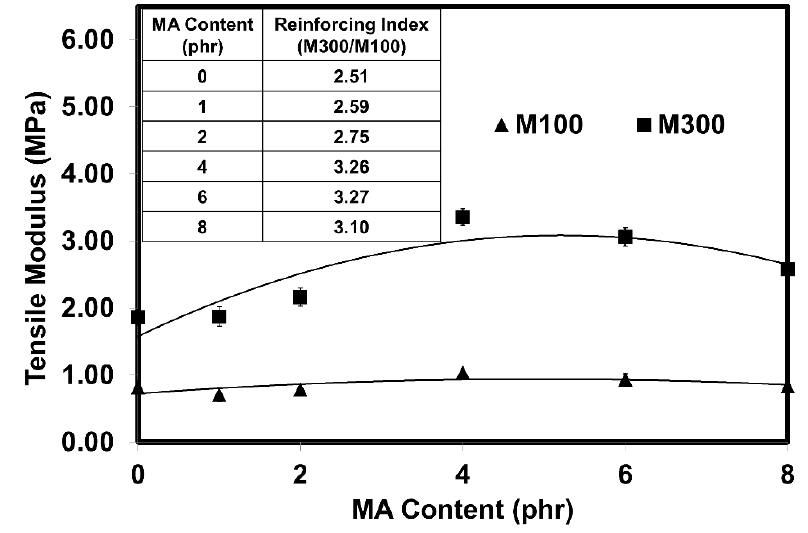
Figure 7. Tensile modulus and reinforcing index of NR/HNT and MNR/HNT composites.